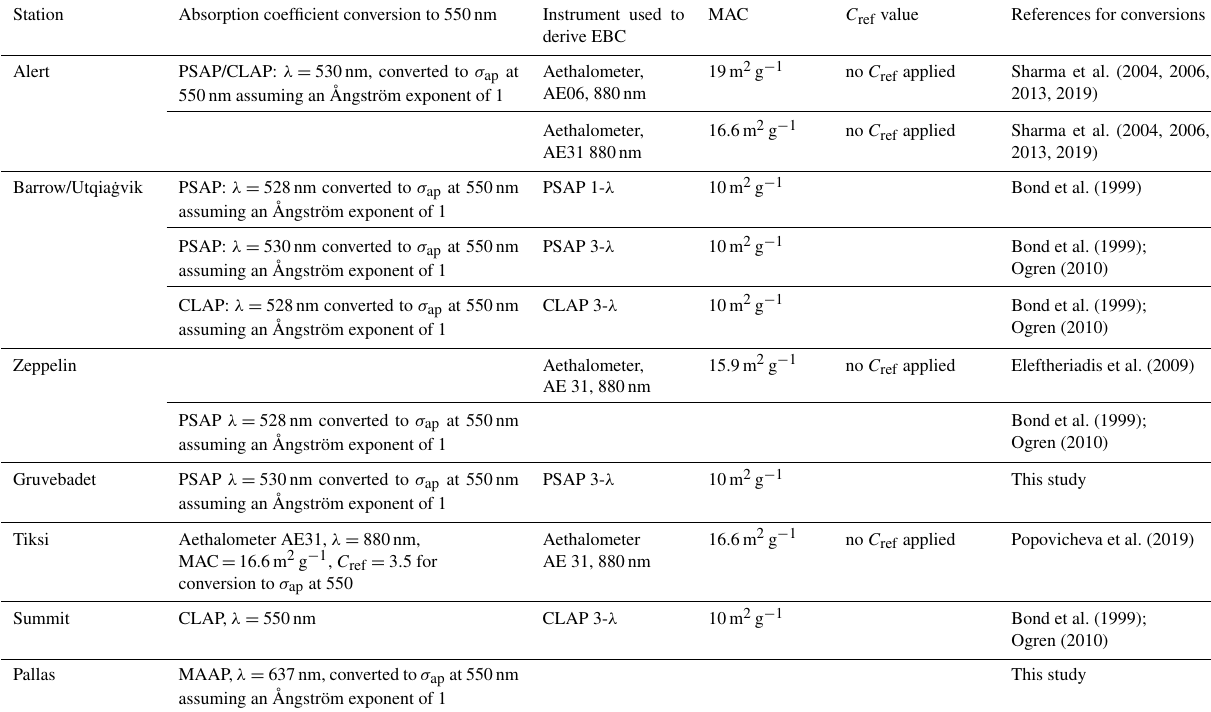
Table 2. Conversion factors for absorption coefficients at 550nm and for the derivation of EBC concentrations.